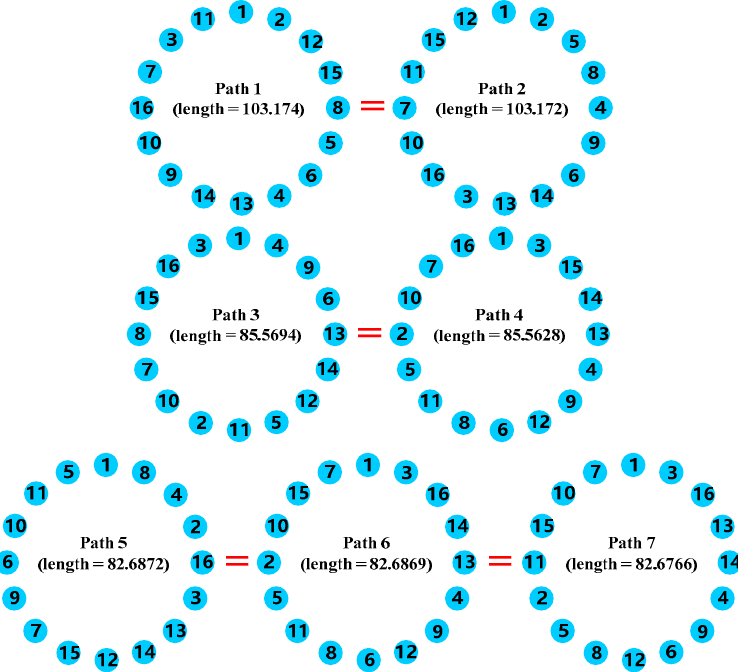
Figure 12. Partial paths of TPSMA under ulysses16 data.